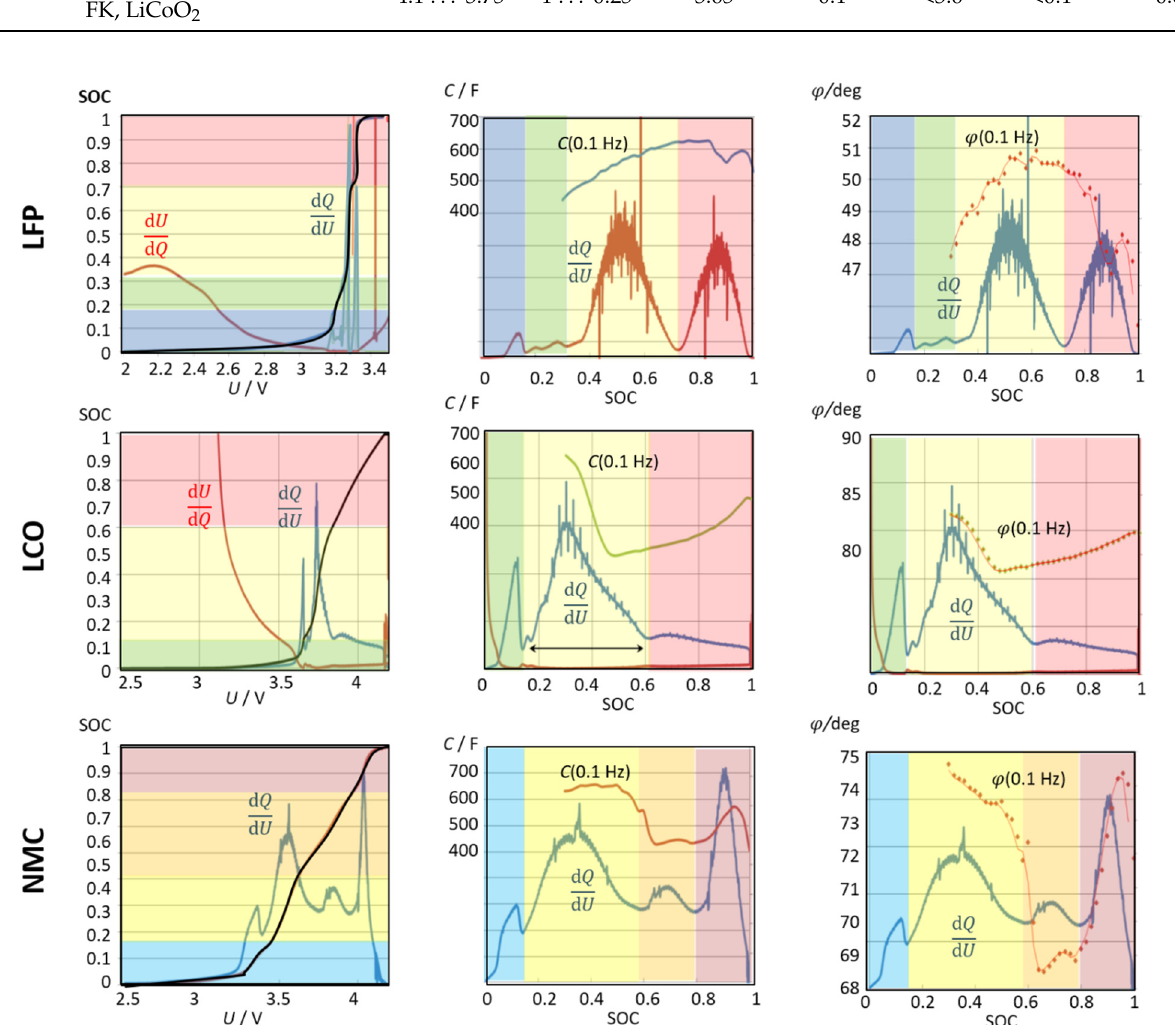
Figure 10. Combination of impedance measurement (capacitance C, phase angle ϕ ) and constant current discharge (differential capacity d Q /d U ) for different cell chemistries. LFP = LiFePO 4 (Lithi- umwerks), LCO = (Sanyo-Panasonic), NMC = LG